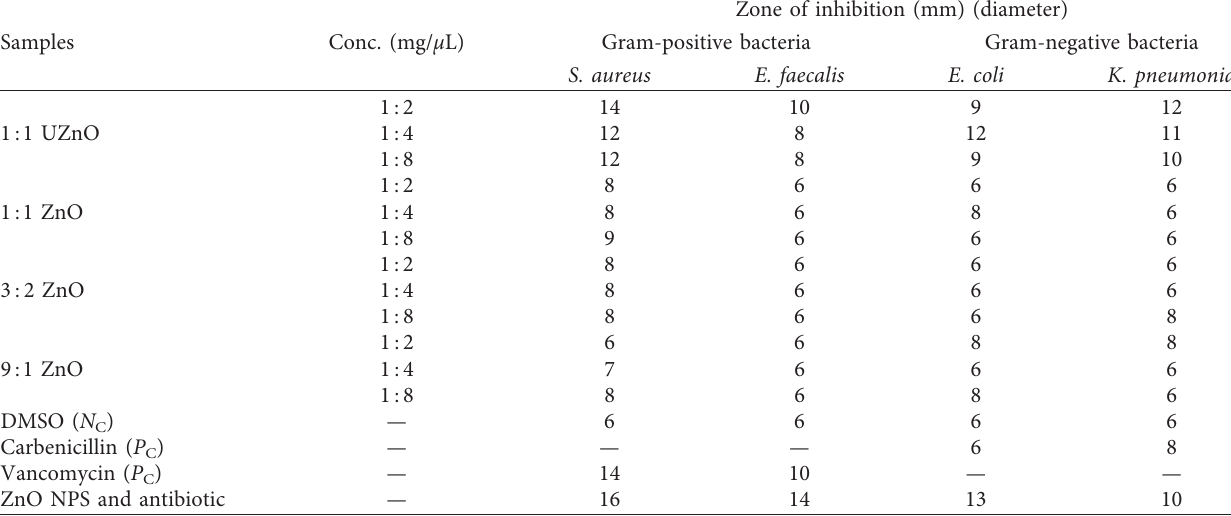
Table 2: Zone of inhibition (mm) of ZnO nanoparticles against Gram-positive and Gram-negative bacterial strains.